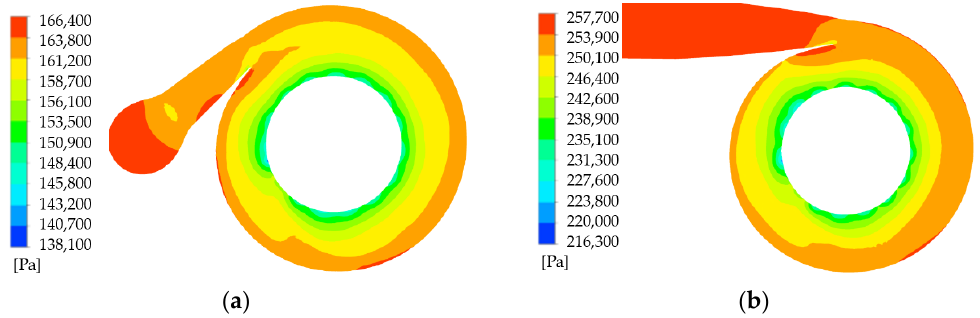
Figure 20. Static pressure contours of diffusers and volutes after improvement. ( a ) First stage. ( b ) Second stage.